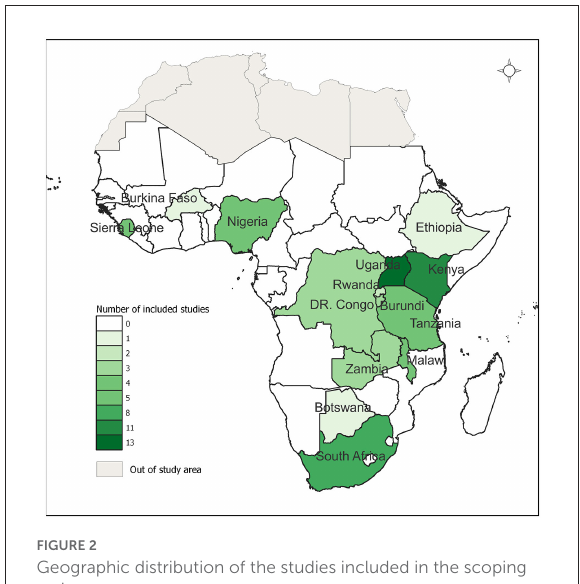
FIGURE2 Geographic distribution of the studies included in the scoping